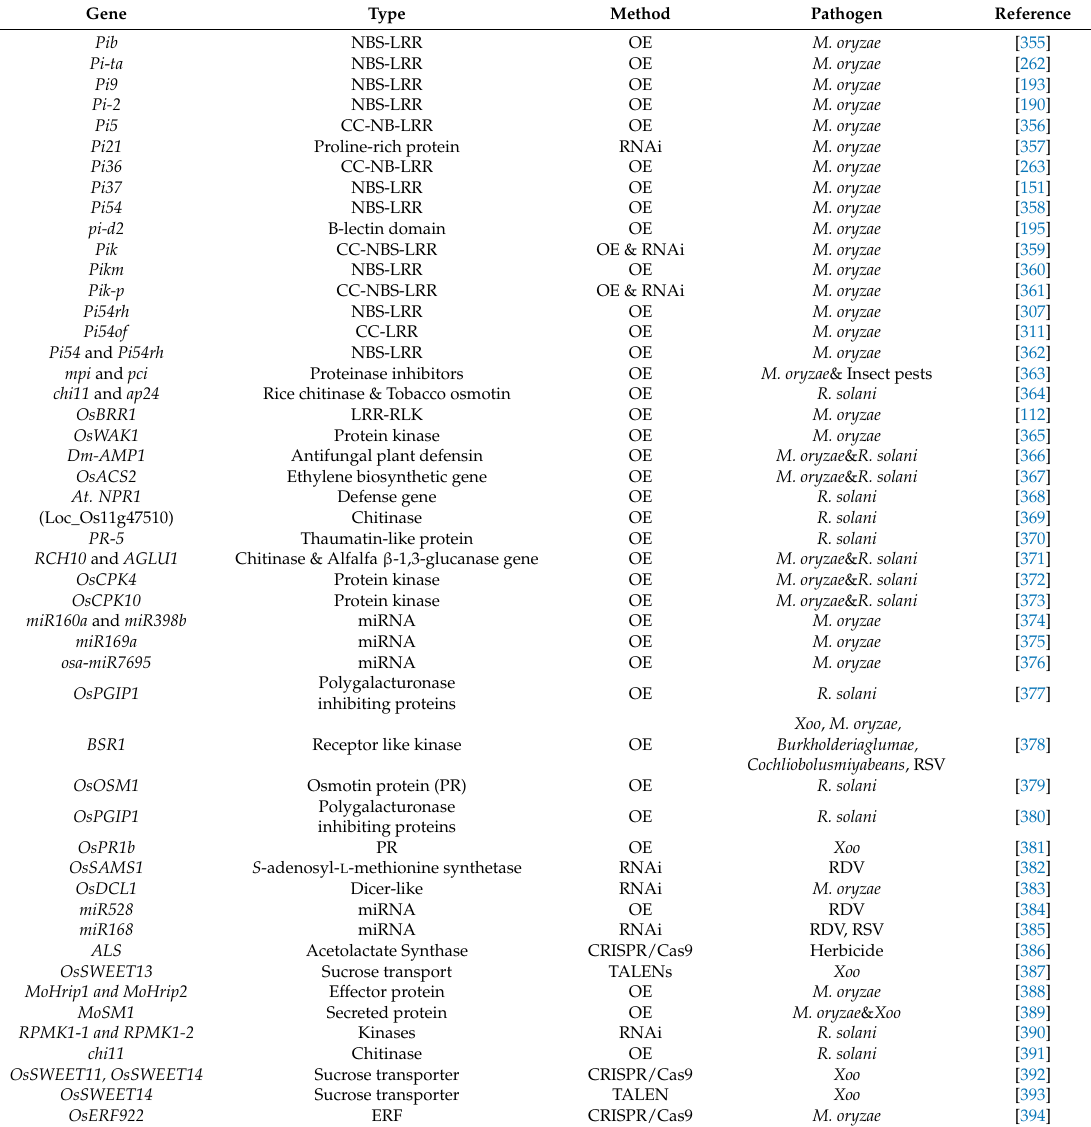
Table 3. List of selected rice resistance and defense response genes characterized by genetic